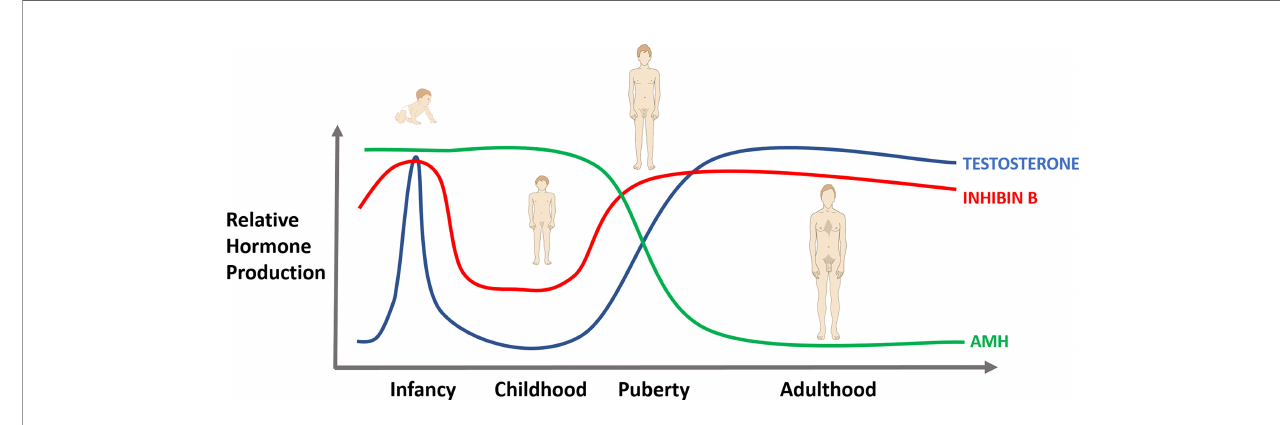
FIGURE 1 | Levels of testosterone, AMH and inhibin B from fetal life